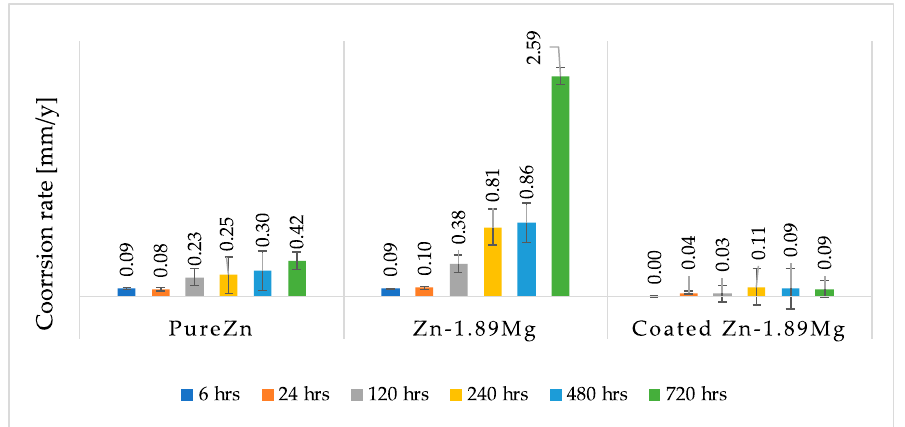
Figure 7. Corrosion rate variations of studied samples immersed in SBF for 6, 24, 120, 240, 480, 720 h.